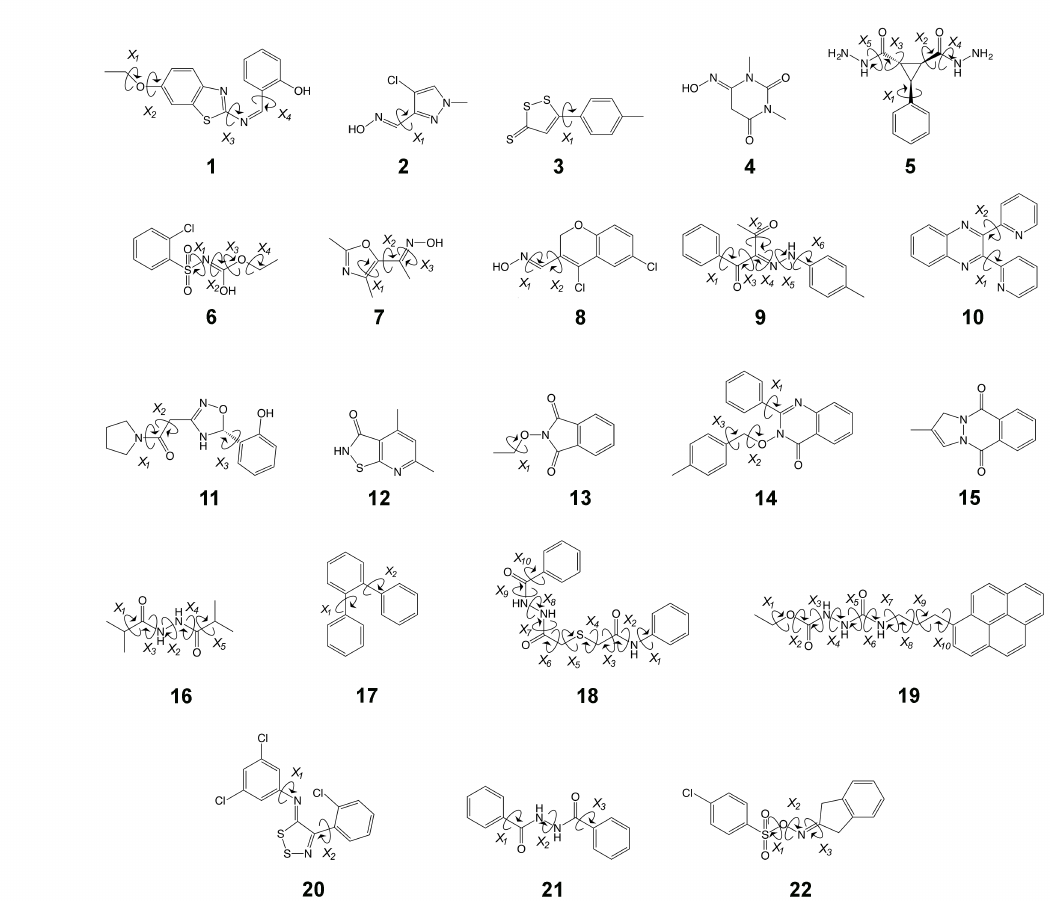
Figure 2. The HiPen dataset modeled herein. Dihedrals that were probed or randomized (see Methods) in this work have been identified for each